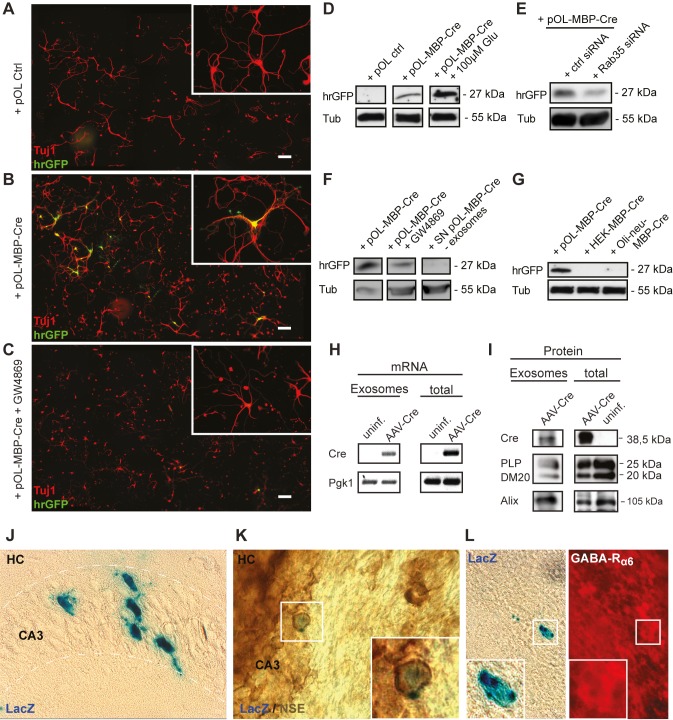
Functional retrieval of exosomal cargo by neurons.(A–G) Boyden chamber co-culture of pOL transduced by recombinant AAV/MBP-Cre (pOL-MBP-Cre) and CN transduced by AAV/CBA-floxstop-hrGFP reporter vector. hrGFP expression indicates Cre-mediated recombination. Tuj1 staining (red) of CN exposed to (A) nontransduced pOL, (B) pOL-MBP-Cre, or (C) pOL-MBP-Cre treated with 5 µM GW4869. Scale bar, 100 µm. (D–G) Reporter gene expression (hrGFP) in target neurons detected by Western blotting of neuronal lysates. CN were exposed to (D) pOL-MBP-Cre treated or not with 100 µM glutamate, (E) transfected with Rab35 or control siRNA, or (F) treated or not with 5 µM GW4869. (F, right lane) Exposure of CN to exosome-depleted culture supernatant from pOL-MBP-Cre does not lead to reporter gene expression in neurons. (G) pOL, Oli-neu cells, or HEK cells transduced with AAV/MBP-Cre co-cultured with CN. (H) Cre RT-PCR and (I) Western blot of exosomes derived from pOL-MBP-Cre or control cells. Pgk1 (mRNA), PLP/DM20, and Alix (protein) are shown as standards. (J–L) Stereotactic injection of exosomes derived from pOL-MBP-Cre into the (J, K) hippocampus (HC) and (L) cerebellum of ROSA26-lacZ reporter mice. β-galactosidase positive cells were stained using X-gal and neurons were stained for (K) neuron-specific enolase (NSE) or for (L) GABA-Rα6. Mice (n = 5) were analyzed 14 d after injection.